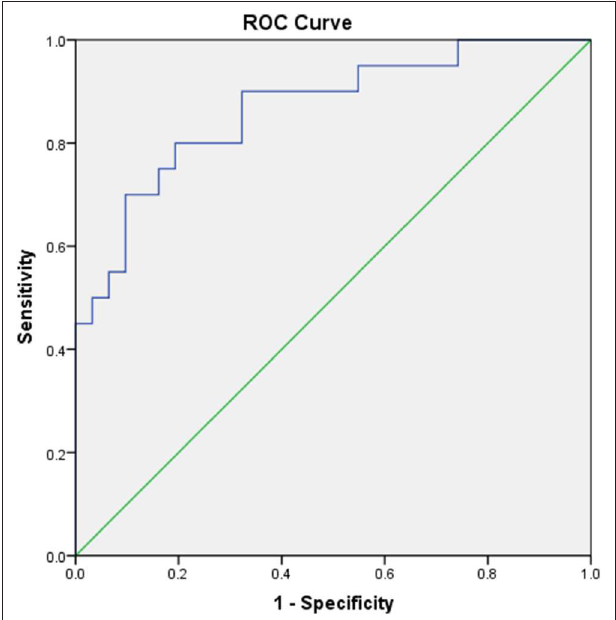
FIGURE 1 | Receiver operating characteristic (ROC) curves assessing the risk of hypothyroidism 2 years after the onset of SAT based on the early maximum TSH value.